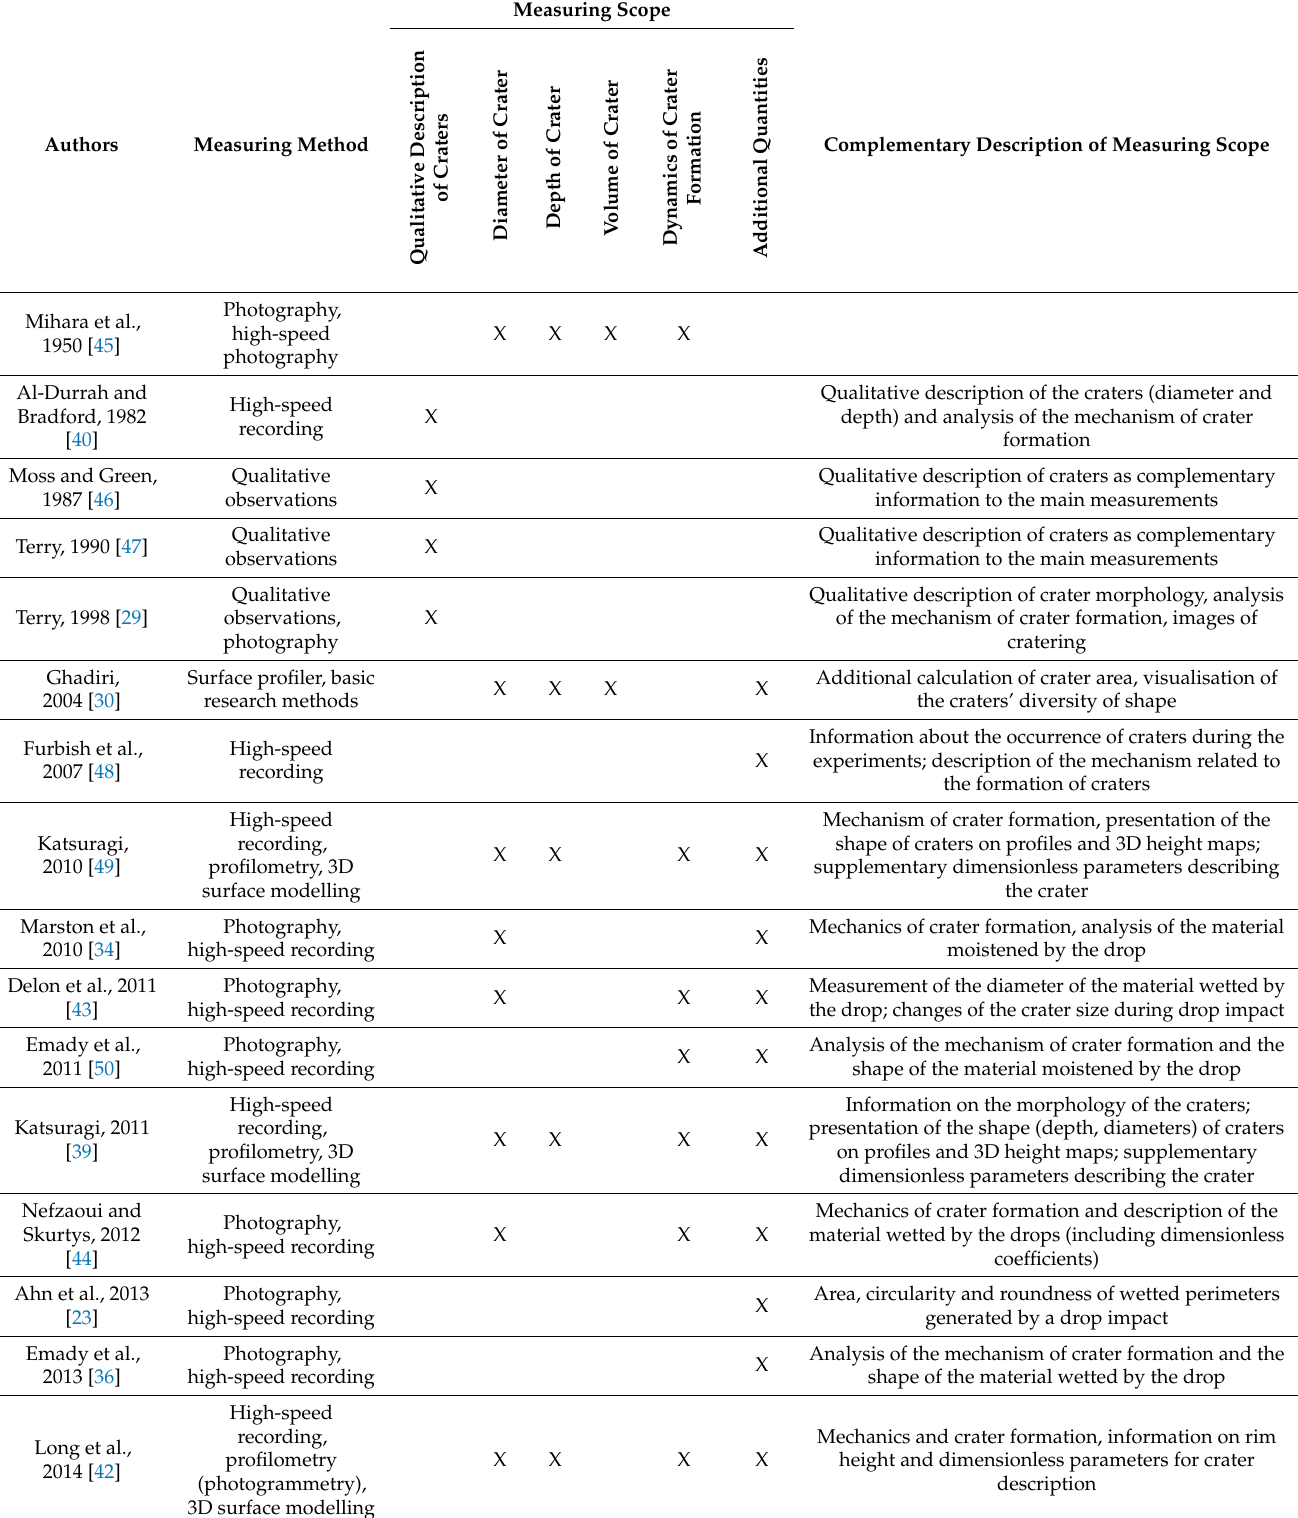
Table 1. Overview of the work involving measurement and analysis of craters after drop impact 1